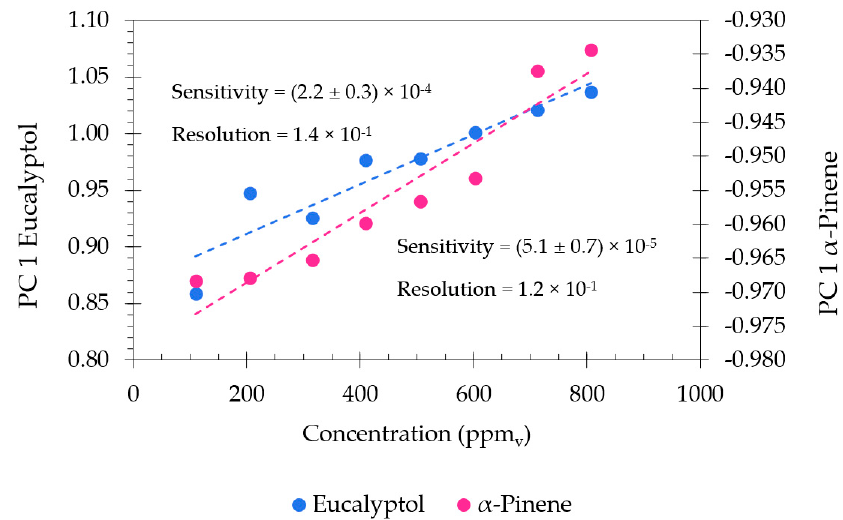
Figure 6. Eucalyptol and α -pinene sensitivity and resolution values achieved using a sensor array of ZnO (100% O 2 ) and (PAH/GO) 5 . PC1 factor scores as a function of the eucalyptol and α -pinene concentrations, ranging from 109 to 807 ppm v .